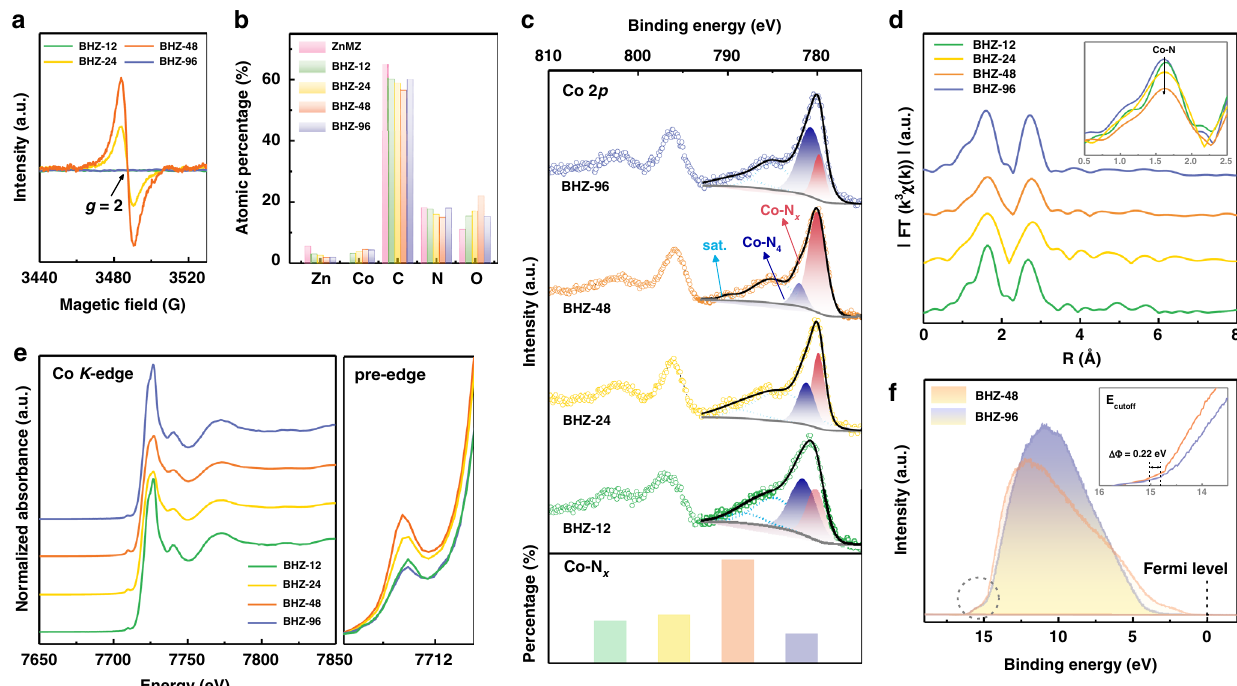
Fig. 2 Chemical composition, electronic state, and coordination environment. a Electron-paramagnetic resonance spectra, b XPS derived element contents, c high-resolution Co 2 p XPS spectra, d R-space Co K -edge EXAFS spectra, and e Co K -edge XANES spectra as well as the ampli fi ed pre-edges of samples in the BHZ series. f UPS spectra of BHZ-48 and BHZ-96 collected using an He I (21.2 eV) radiation. Inset: enlarged view of the secondary electron tail